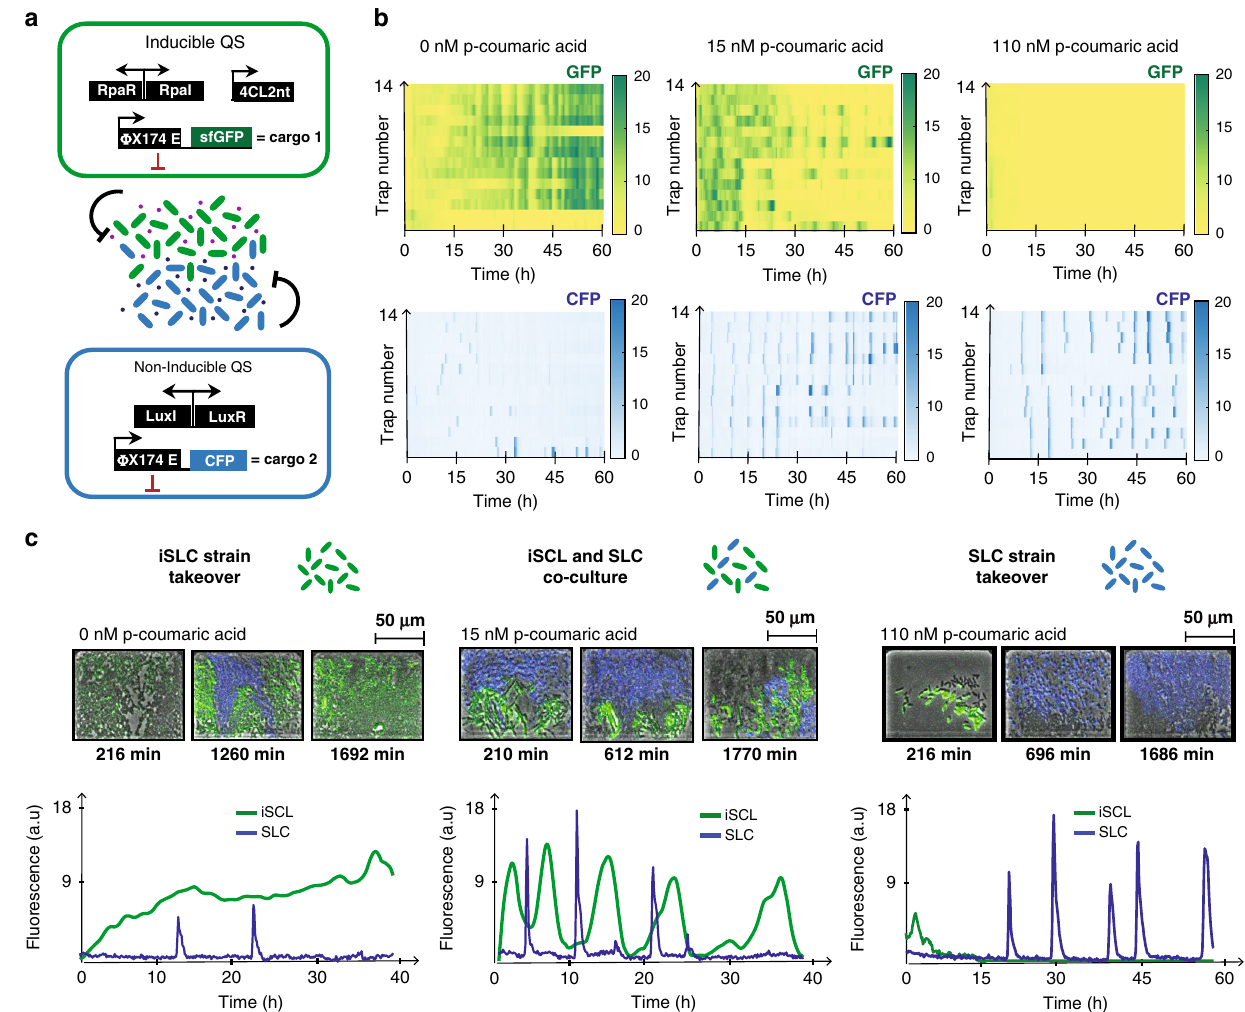
Fig. 4 iQS enabled modulation of orthogonal multi-strain dynamics. a Schematics representing co-culture of the two strains used with orthogonal inducible (iSLC) and non-inducible (SLC) quorum sensing, respectively. b Heatmaps representing the fl uorescence time traces of all 14 traps present per column of the device. Top rows show the GFP values and bottom rows the CFP values. Fluorescence signals are used as a proxy for population density. c Shown at the top are Movie stills of the co-culture for three inducer concentrations at multiple time points. The corresponding fl uorescence time traces for GFP and CFP are plotted at the bottom. Source data are provided as a Source Data fi